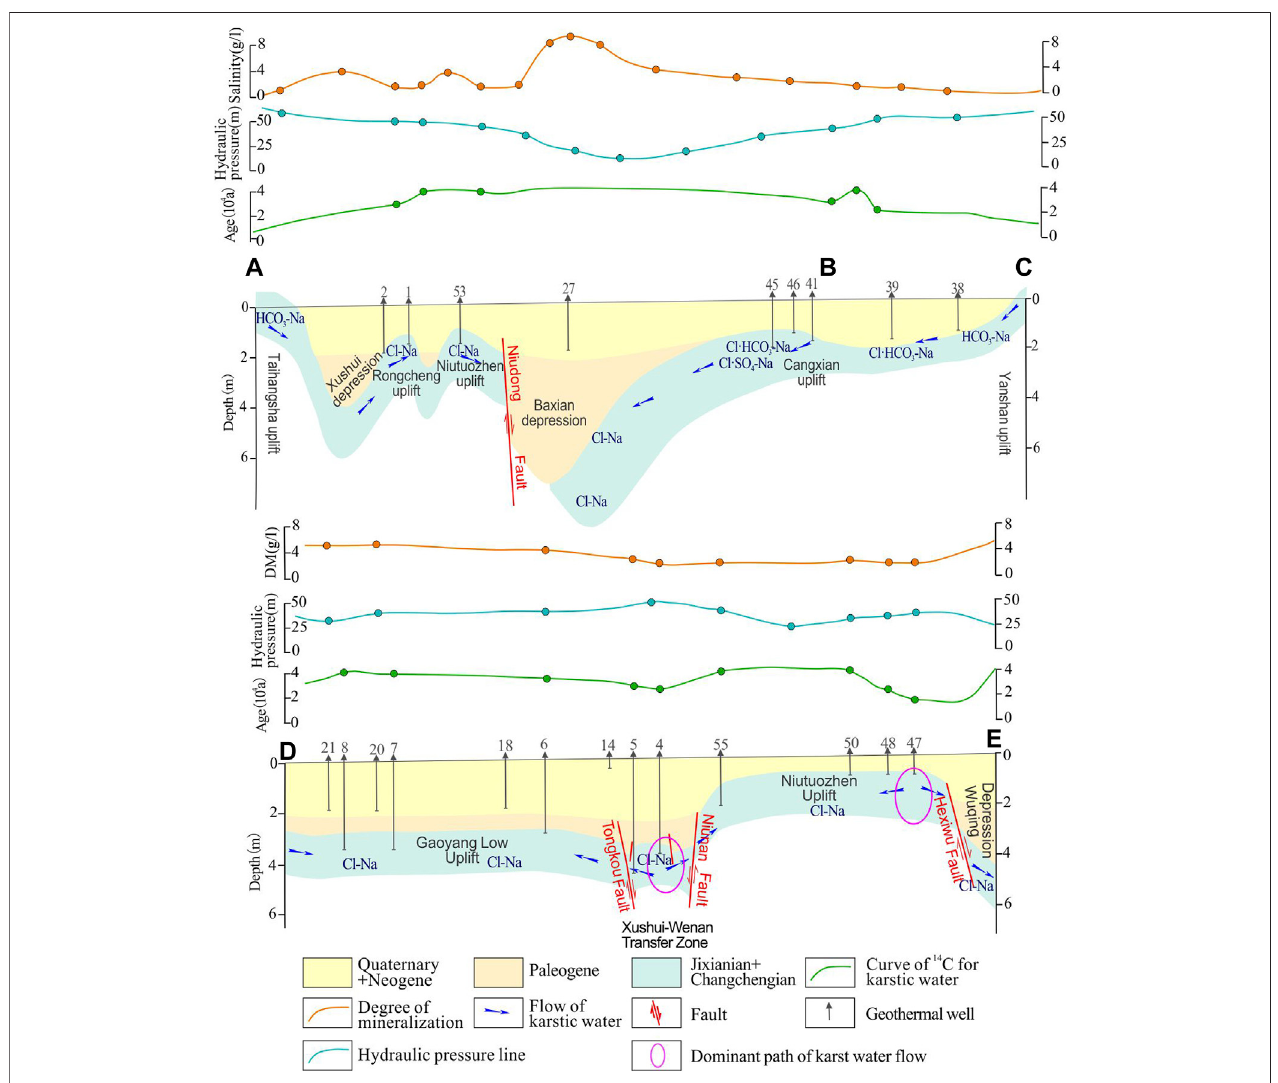
FIGURE 7 | Geological cross-section along section line (A – E) on the map of Figure 2 of the study area.